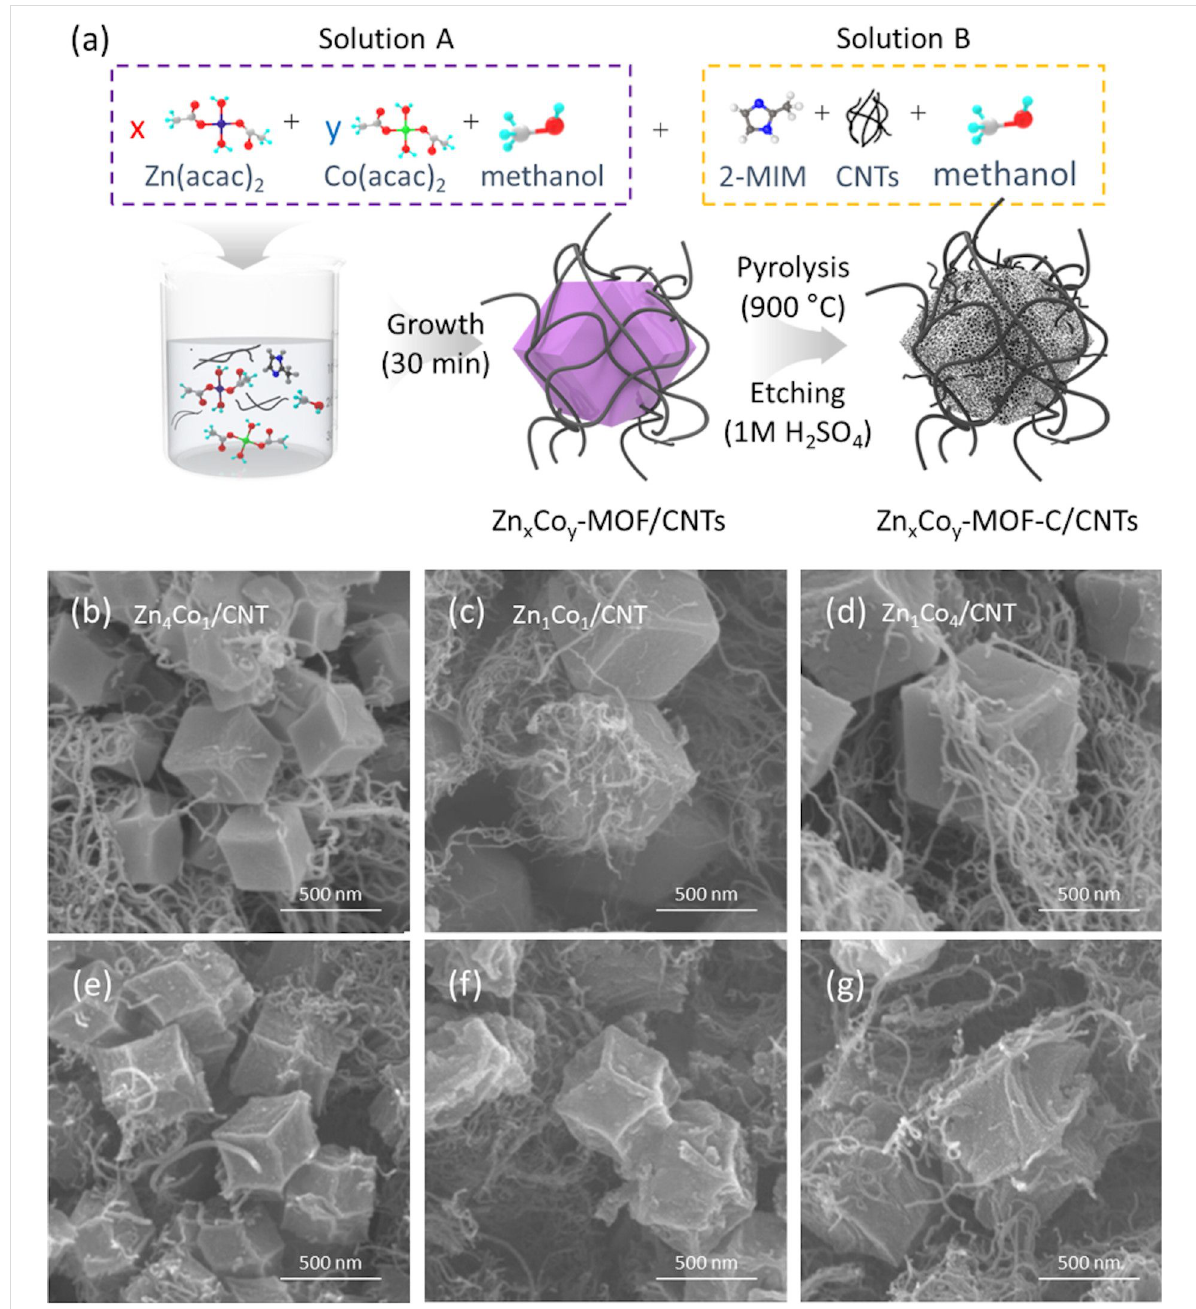
Figure 1: (a) Design and synthesis of Zn x Co y –CNT. FESEM images of (b, c, d) as-prepared and (e, f, g) etched composites. (b, e) Zn 4 Co 1 –CNT, (c, f) Zn 1 Co 1 –CNT, and (d, g) Zn 1 Co 4 –CNT.